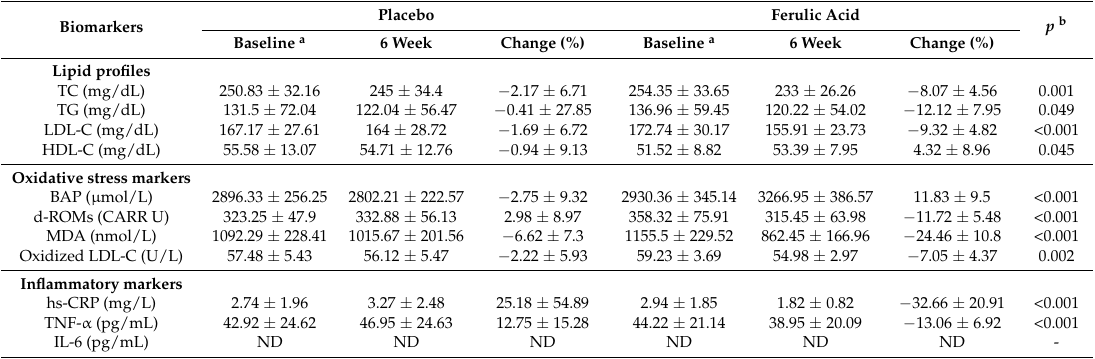
Table 3. Lipid Profile, Oxidative Stress, and Inflammatory